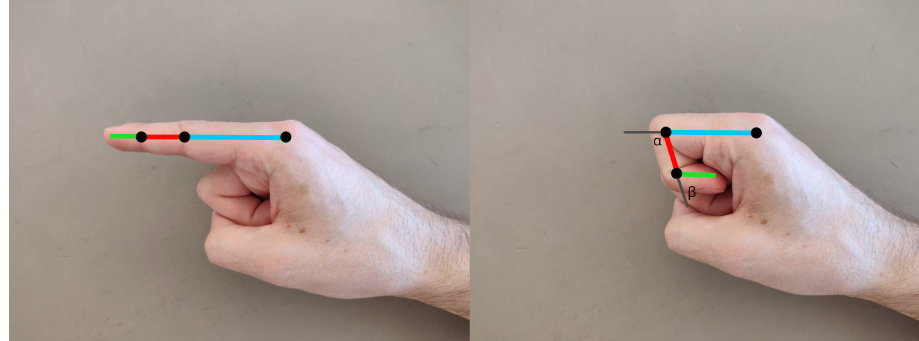
Figure 2. Straight and curled finger angles.